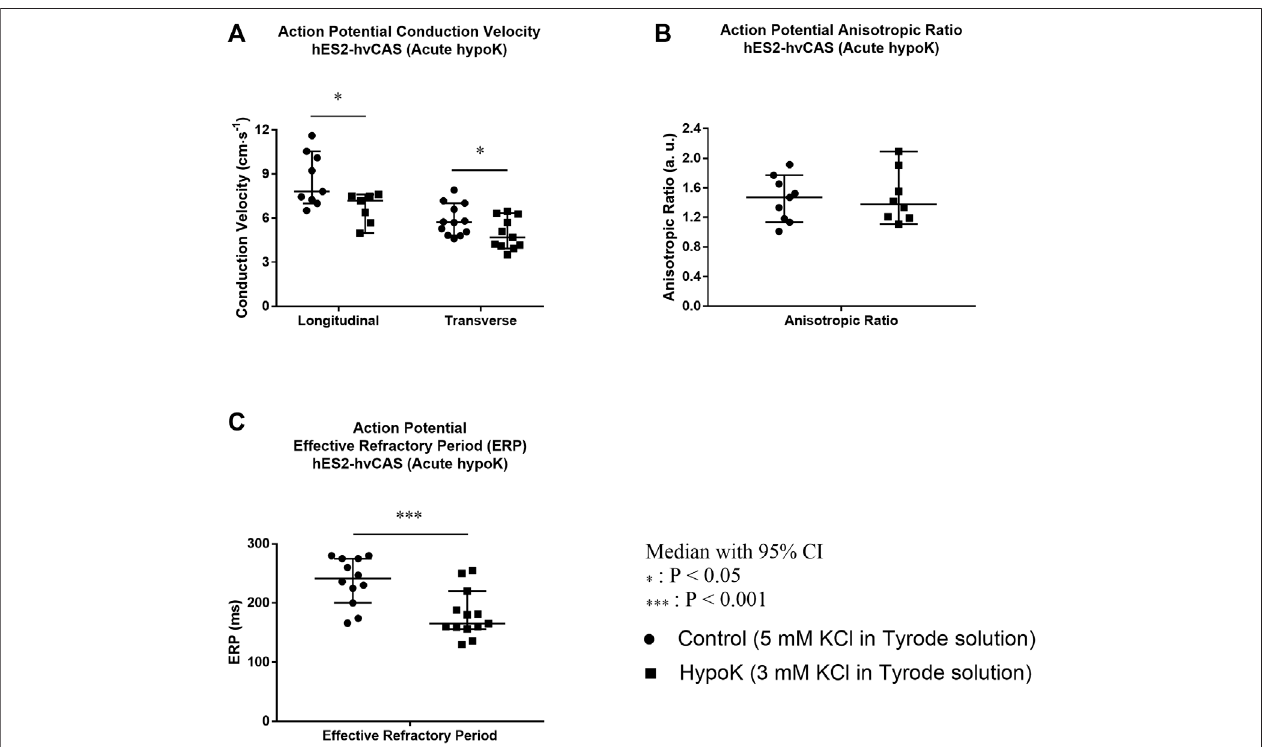
FIGURE 5 | Human embryonic stem cell (hES2)-derived human ventricular cardiac anisotropic sheet (hvCAS) paced at 1.5 Hz during acute hypokalaemic (hypoK) experiment where the treatment was for 15 min before data acquisition. Number of samples is represented by n where the fi rst number refers to control (5 mM KCl in Tyrode solution) samples and the second number refers to hypoK (3 mM KCl in Tyrode solution) samples. (A) Action Potential (AP) Longitudinal Conduction Velocity (LCV)( n (cid:1) 9,7)andTransverse Conduction Velocity(TCV)( n (cid:1) 12,11). Thevelocitywasmeasured bycalculatingthespeedofAPpropagationfromonepointtothe other. (B) AP Anisotropic Ratio (AR) which is the ratio of LCV to TCV. ( n (cid:1) 9, 8). (C) AP Effective Refractory Period (ERP). ( n (cid:1) 12, 13) Conduction Velocity decreased in hypokalaemiccondition(asterisk, p < 0.05forbothLCVandTCV).ERPofhvCASpacedat1.5 Hz(8trains)followedbyanextraprematurestimuluswhichwasgradually shortened to fi nd ERP was decreased in hypokalaemic condition (asterisk, p < 0.001). AR is between 1.4 and 1.8, resembling more closer to the native human ventricle (AR (cid:1) 3) in normokalaemia as well as in hypokalaemia.